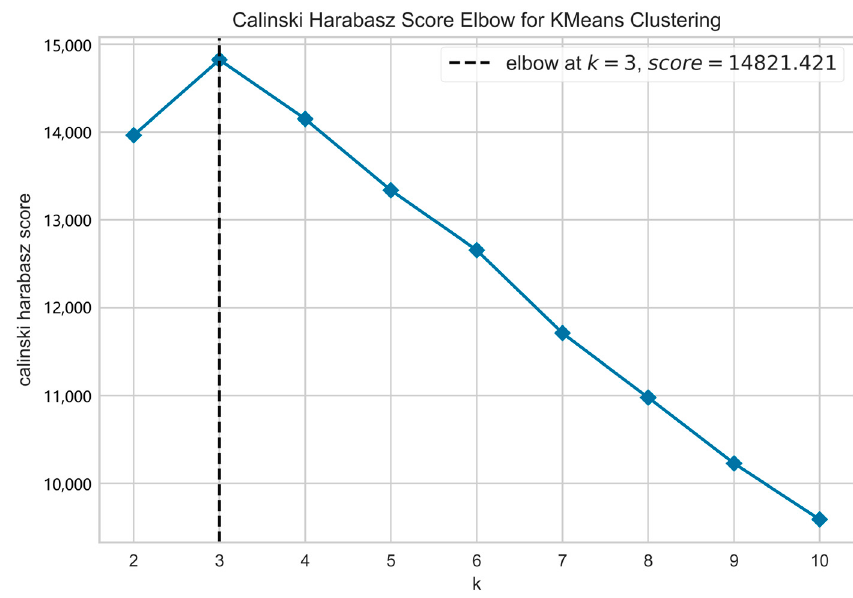
Figure 9. Elbow method estimated by